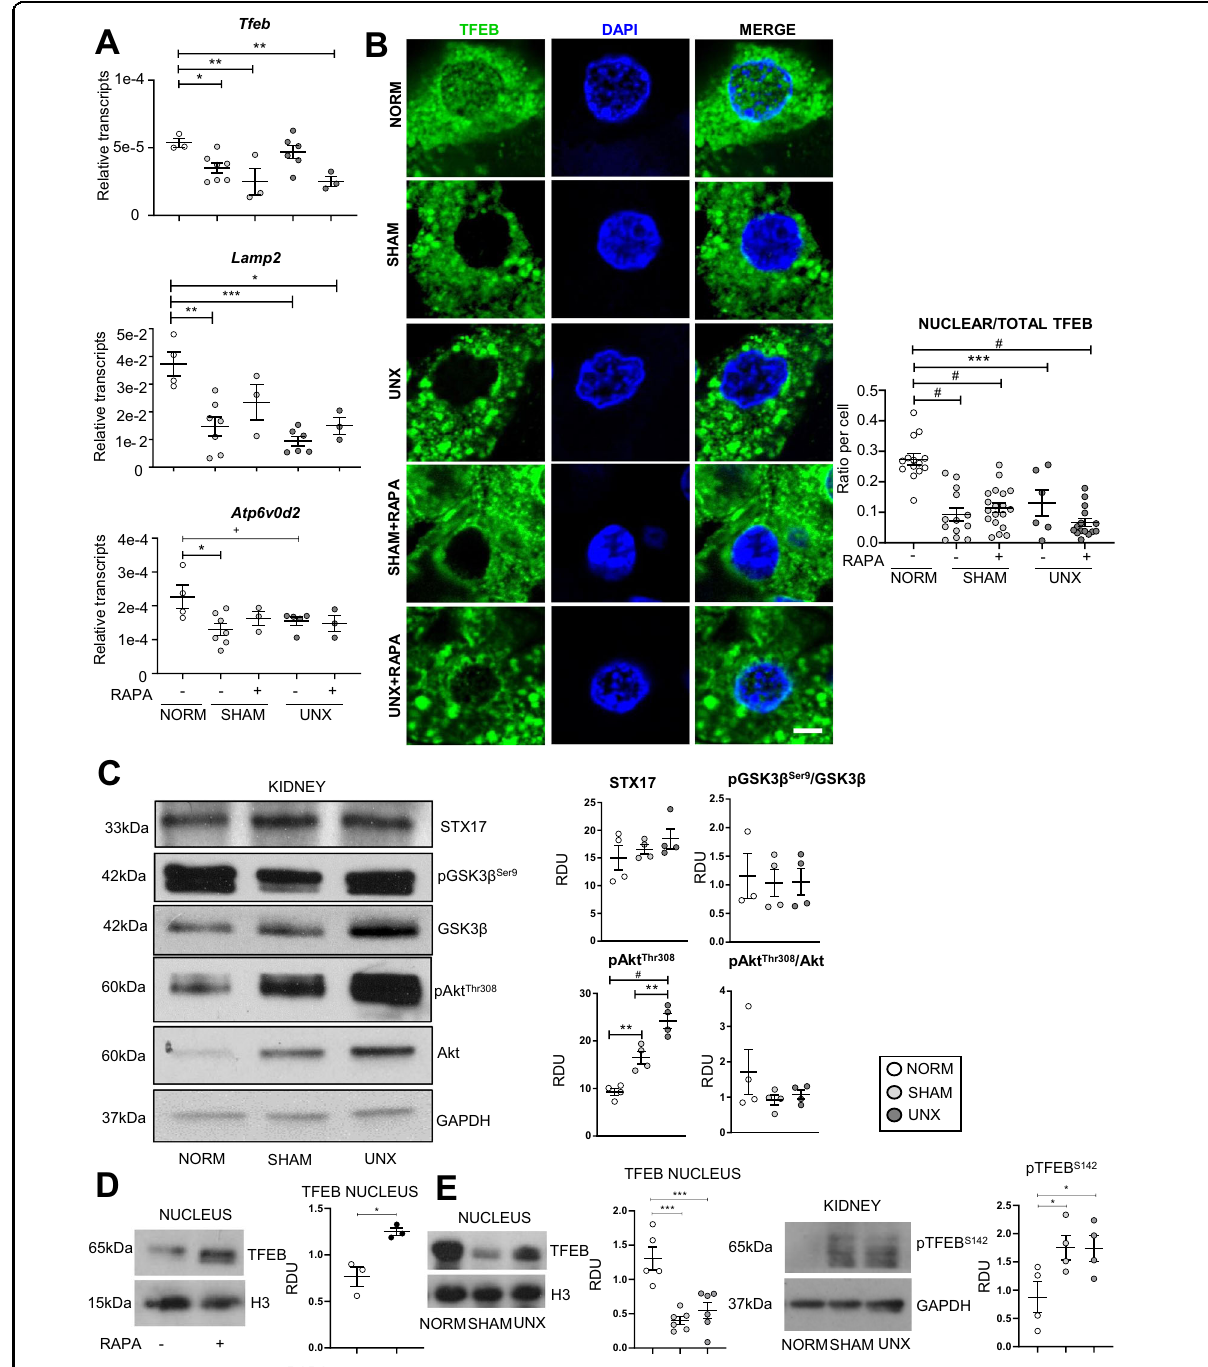
Fig. 2 Sham surgery and unilateral nephrectomy are associated with a lysosomal defect. Mice underwent either no surgical manipulations (NORM), sham surgery (SHAM), or unilateral nephrectomy (UNX) and after 2 h the contralateral kidney was harvested. A qPCR analysis of TFEB- downstream genes Tfeb , Atp6v0d2 , and Lamp2 . B Representative proximal tubular cell images of TFEB nuclear versus cytoplasmic localization with quanti fi cation showing readings in duplicate for each mouse (Scale bar = 5 µm). C Immunoblot analysis for STX17, pGSK3 β Ser9 , GSK3 β , pAkt Ser308 and Akt. D Immunoblot analysis for TFEB in nuclear extracts from rapamycin -treated (RAPA) mice. E Immunoblot analysis for TFEB in nuclear extracts from NORM, SHAM and UNX mice. F Immunoblot analysis for pTFEB S142 in whole kidney extracts from NORM, SHAM and UNX mice. Quanti fi cation is corrected for GAPDH unless otherwise indicated. + P = 0.07, * P < 0.05, ** P < 0.01, *** P < 0.001, # P < 0.0001. RDU = relative densitometry units corrected for GAPDH. H3 = Histone